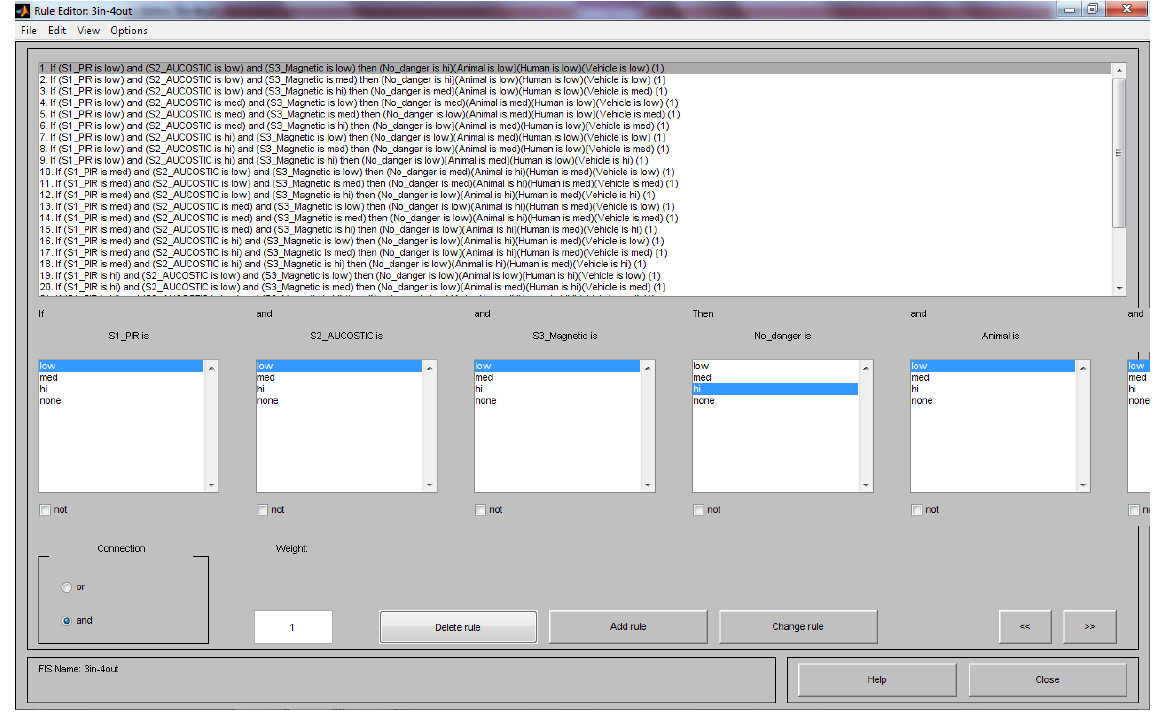
Figure 9. Rule editor of input/ output membership functions.